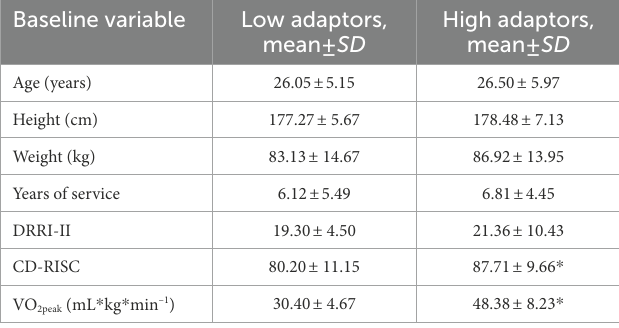
TABLE 3 Participant characteristics ( N = 48) of low adaptors ( n = 20) and high adaptors ( n = 28). Baseline variable